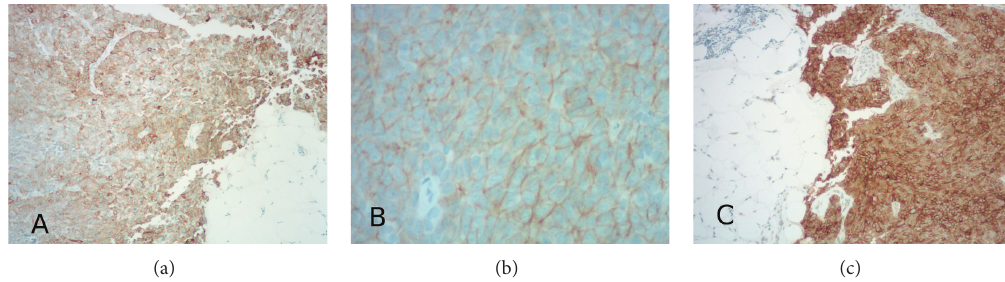
Figure 2: 10x Pankeratin positive (a), 40x CD5 Brown-Orange rim around each of the tumor cells (b), and 10x CD117 highlights the tumor and contrasts with the surrounding fat and stromal tissue (c).